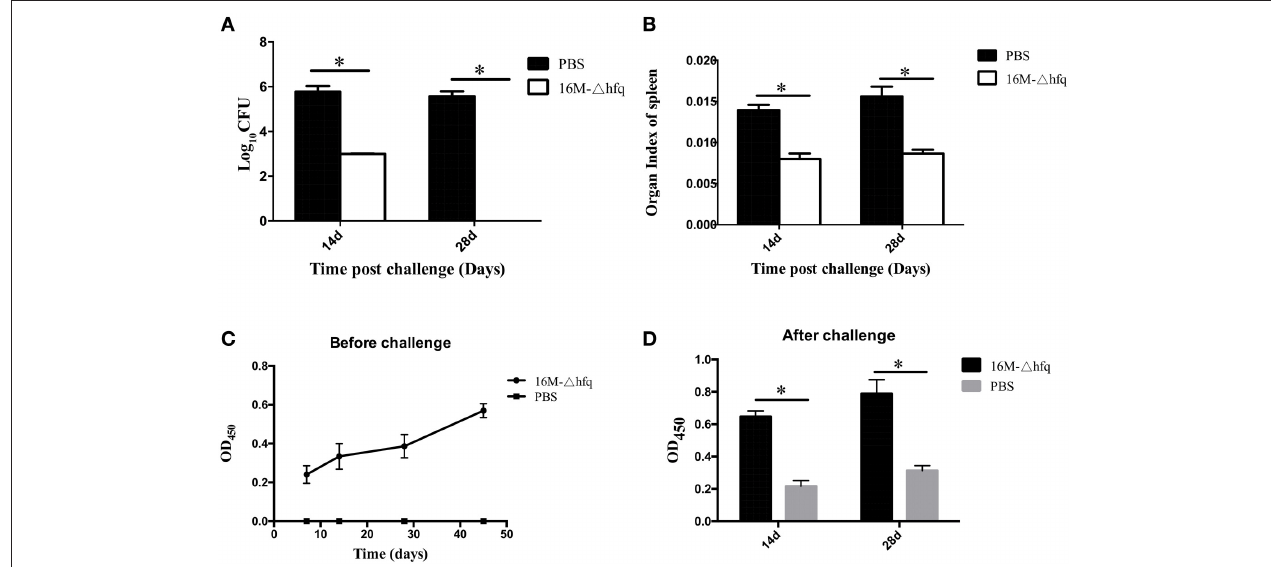
FIGURE 4 | Protection efficacy and antibody induction of the hfq- deletion mutant. BALB/c mice were immunized with 16M △ hfq or PBS (negative control), and at 45 days post-immunization the mice were challenged with 16M. Fourteen and twenty eight days post the challenge, bacteria were isolated from the spleens and enumerated (A) , and organ indexes were calculated (B) . Antibody levels were detected at 7, 14, 28, and 45 days before challenge (C) , 14 and 28 days post-challenge (D) . The data were expressed as the mean log 10 CFU ± SD ( n = 5 ). Significant differences between the mutant and parent strain were indicated as follows: * P < 0.001